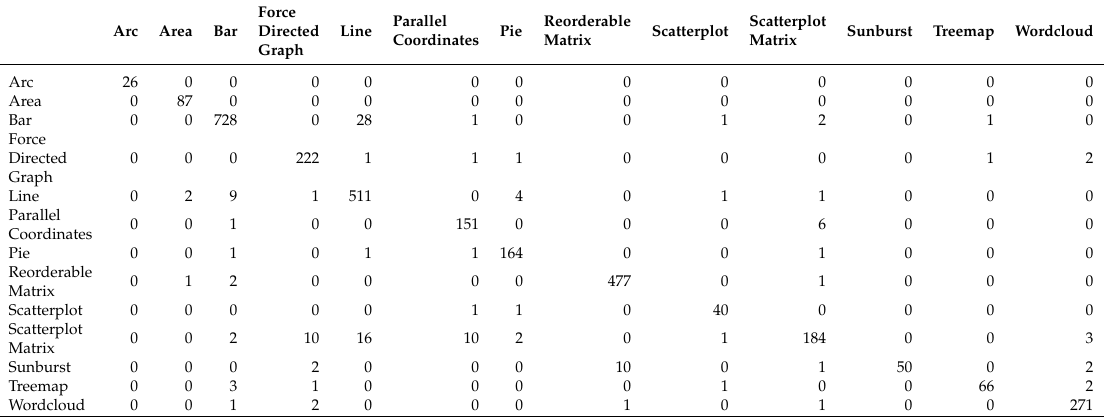
Table 3. Results of Chart Classification Confusion Matrix of the best model.